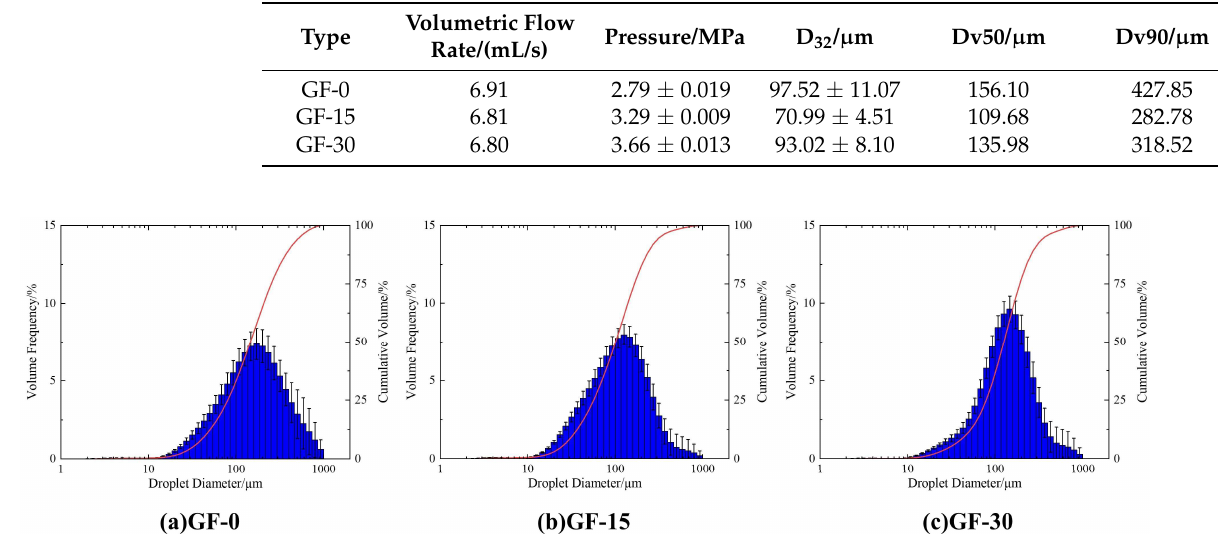
Figure 10. Droplet size distribution of different gelled fuels using self-excited oscillation nozzles.